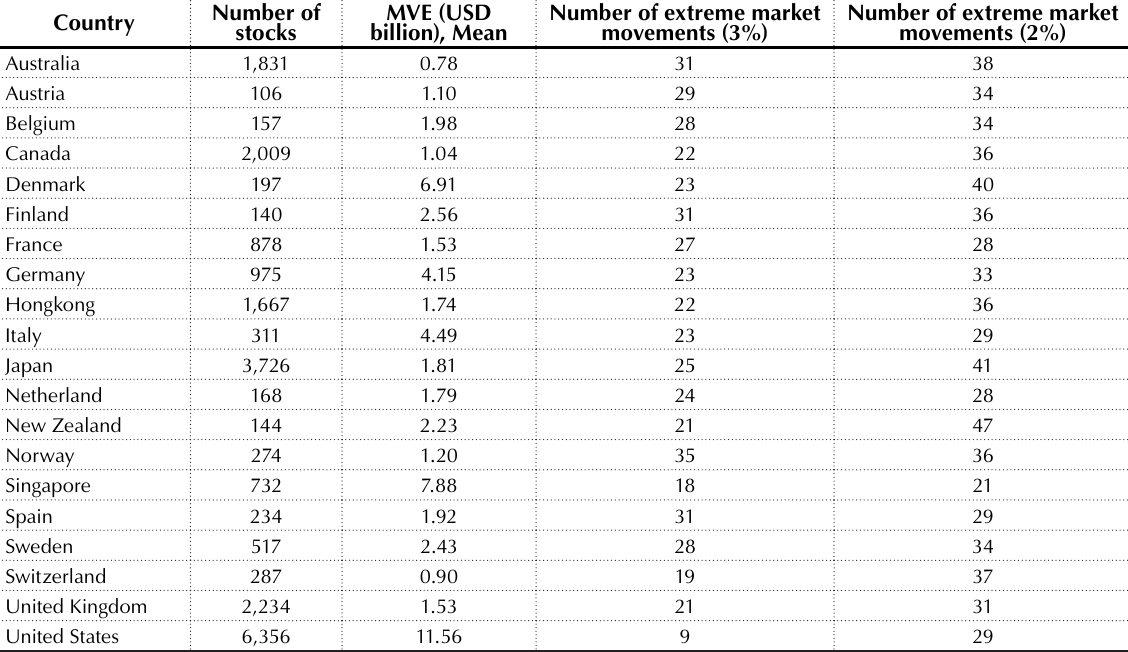
Table 1. Summary statistics for different